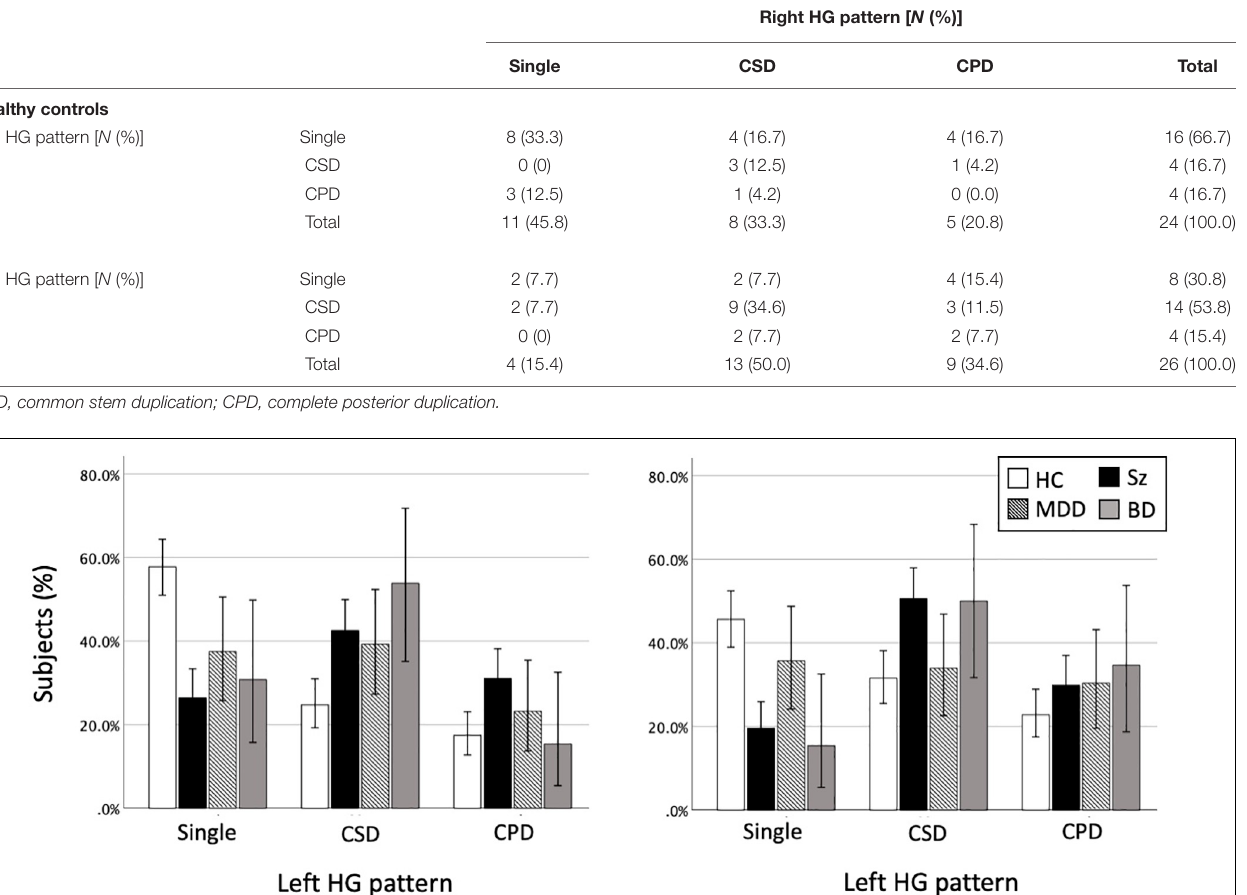
TABLE 2 | Gyrification pattern of Heschl’s gyrus (HG) for both hemispheres in the bipolar disorder (BD) cohort.